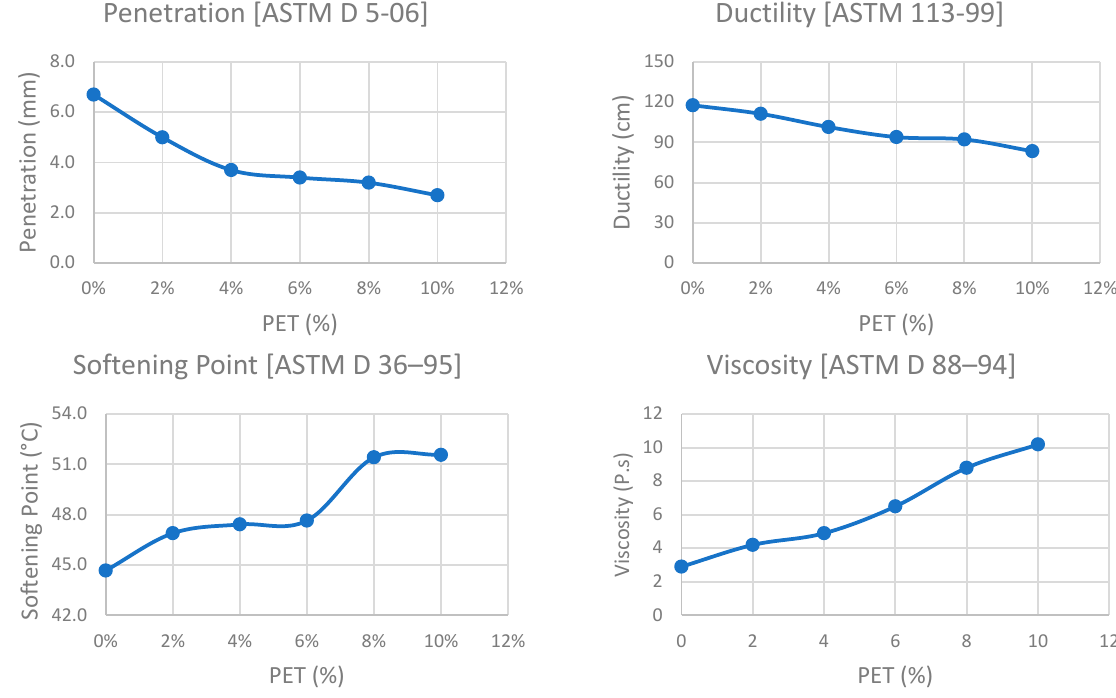
Figure 7. Preliminary Testing on PMB.